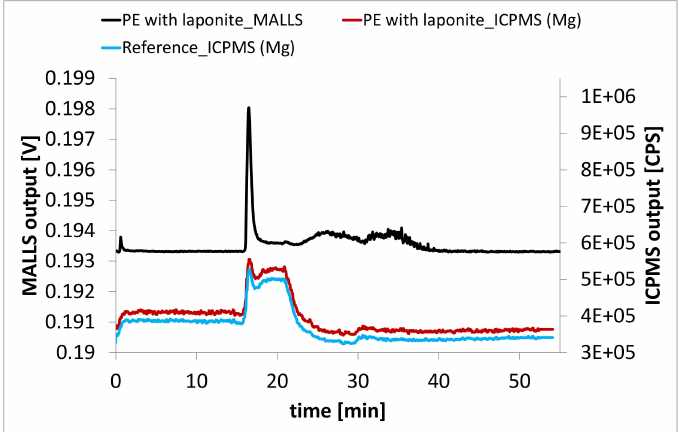
Figure 8. AF4/MALLS/ICP-MS fractograms of a test sample that was swollen first and then abraded: The same sample that caused a signal via MALLS detection (black) at elution times relevant for laponite did not cause a signal for Mg via ICP-MS (online) detection (red). Via AF4/ICP-MS detection no difference between abrasion from test samples and reference samples without laponite (blue, shifted by − 2.5 × 10 4 CPS for better differentiation) could be